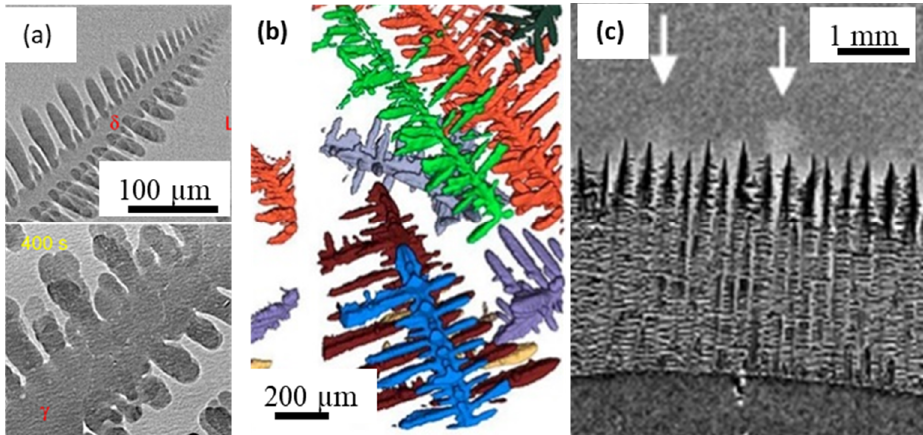
Figure 7. In situ imaging of a high-temperature metallic system: ( a ) Radiographic images showing fragmentation of γ grains induced by a massive-like δ – γ transformation in 0.45C steel (after Yasuda et al. [105] ( b ) Dendritic pattern formation in Ni, Fe, and Co alloys using fast synchrotron tomography. A cooling rate of 0.1 K/s was employed, with each tomographic scan performed in about 1–2 min, (after Azeem et al., [23]). ( c ) Segregated channels during solidification of Ni-based alloy captured via radiographic imaging, (after Reinhart et al., [59]) Permitted for reuse from respective publishers.